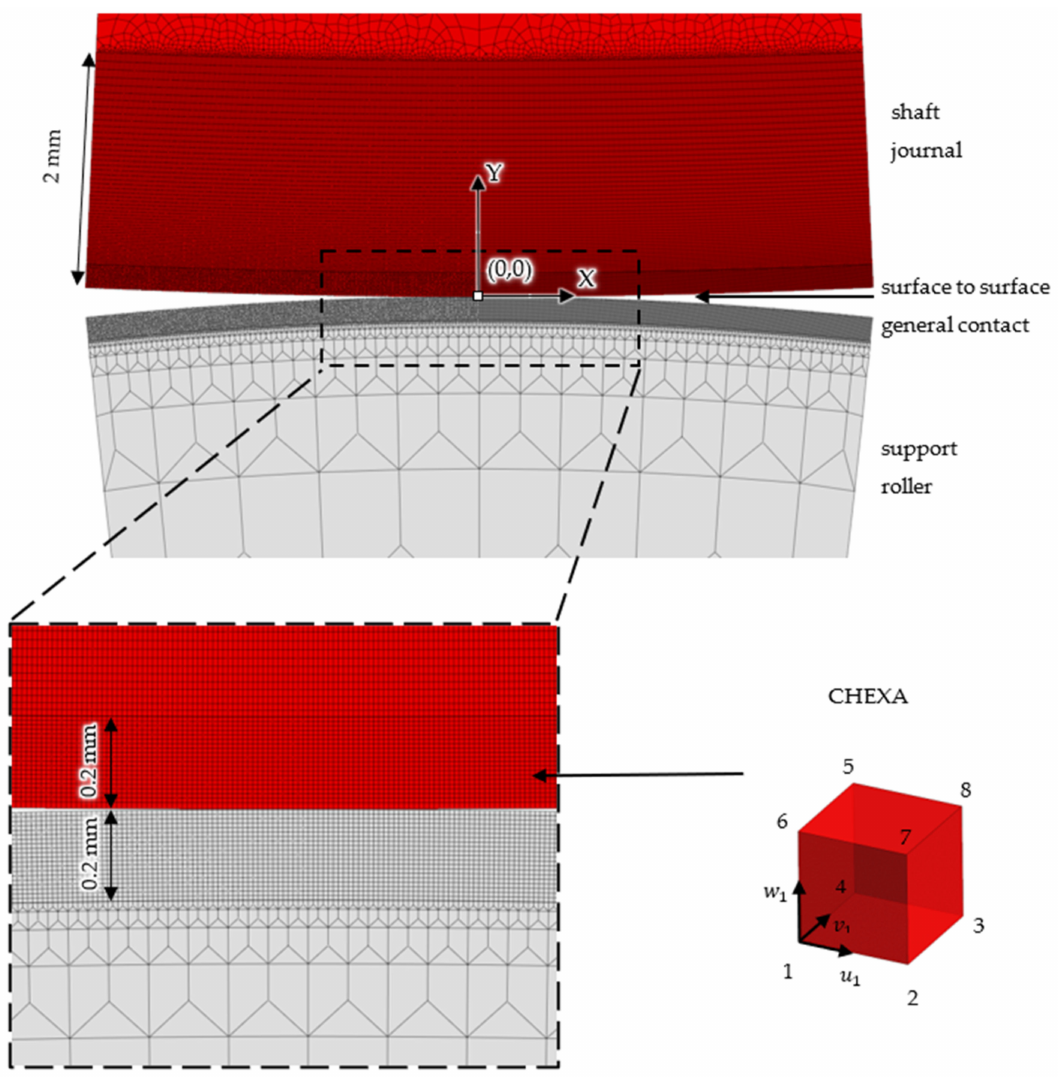
Figure 6. Division with finite elements with a side of 0.01 mm, near the contact of the shaft with the support